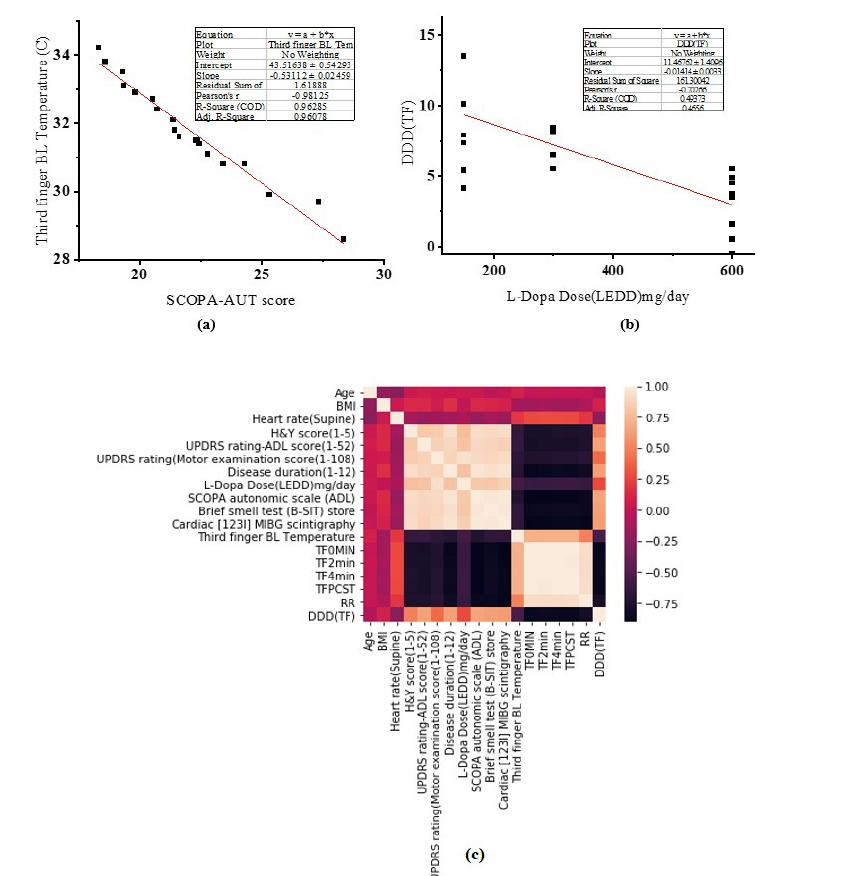
Figure 6. ( a ) Correlation of third finger baseline temperature with SCOPA-AUT score; ( b ) correlation of DDD with LEDD mg; ( c ) correlation of various parameters is shown in the